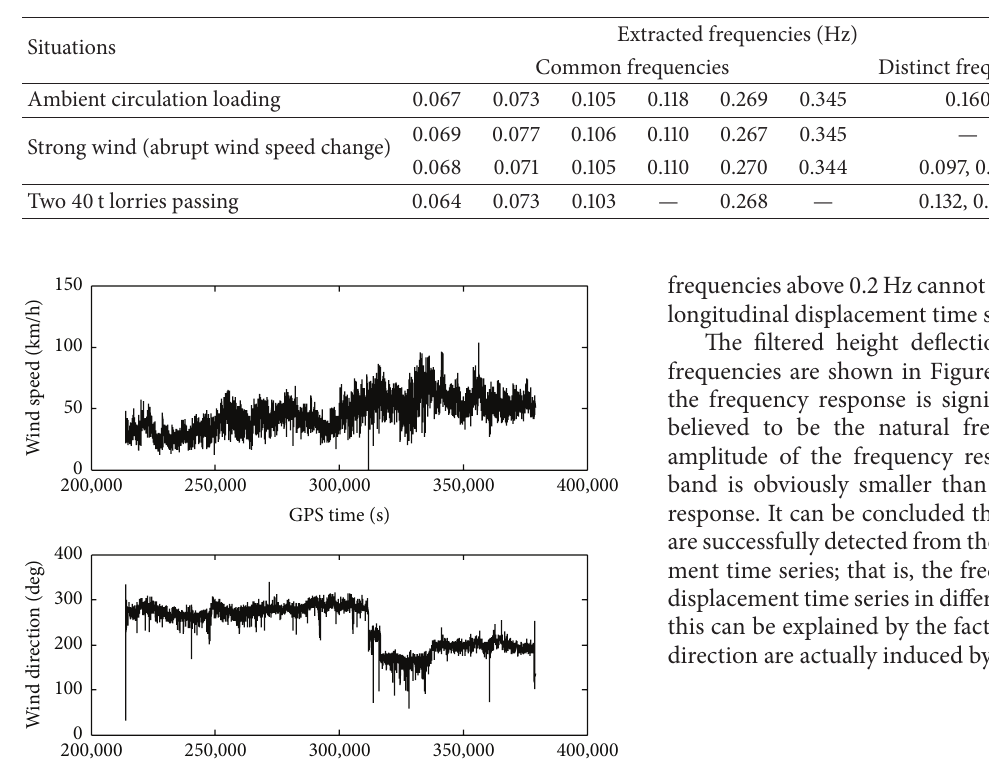
Figure 10: The filtered height displacements and corresponding frequencies. Table 1: Vibration frequencies extracted from lateral GPS measurements ( 𝑋 direction of BCS).